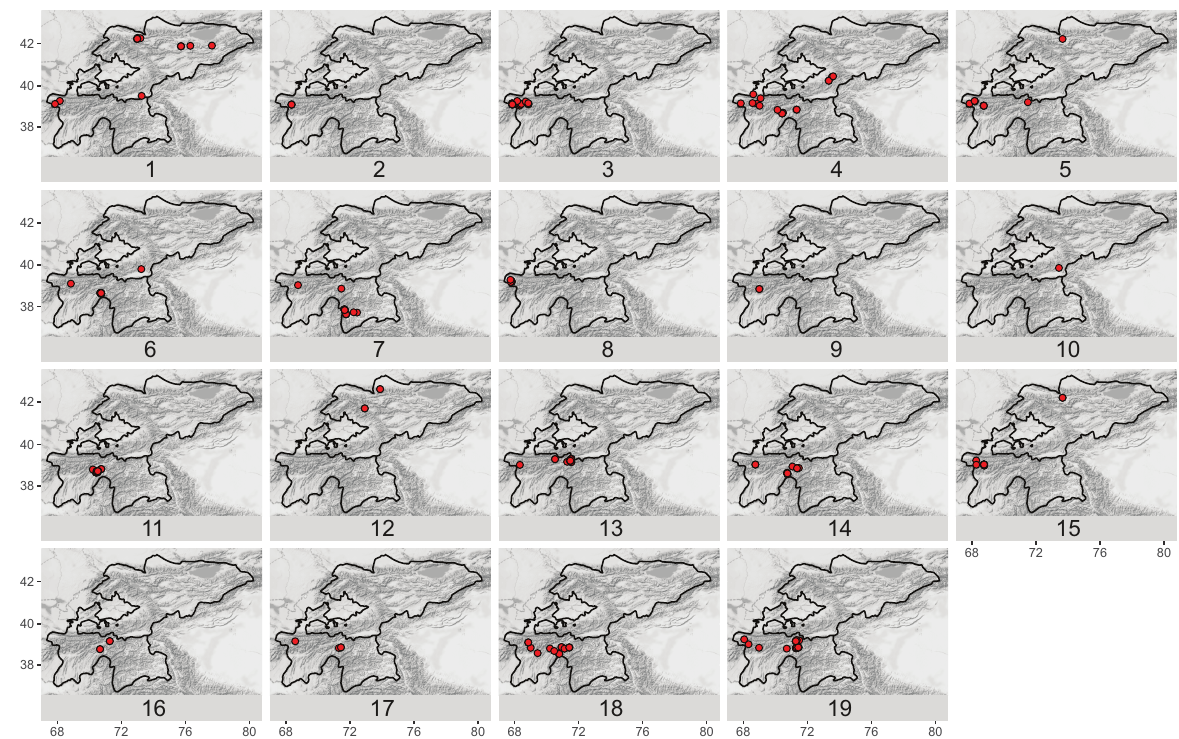
Figure 4. Distribution of relevés assigned to the particular vegetation units (n = 244). The name of syntaxon (1–19) are written in the Syntaxonomic